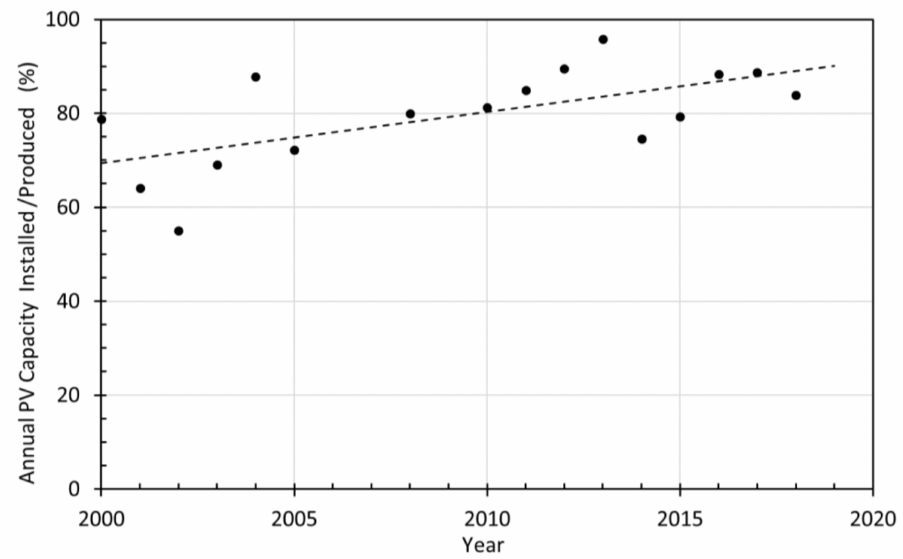
Figure 1. Annual installed PV capacity as a % of annual PV production (MW) vs. year. Sources: Adapted from [25] for installed capacity and [66] for annual production. Line of best fit